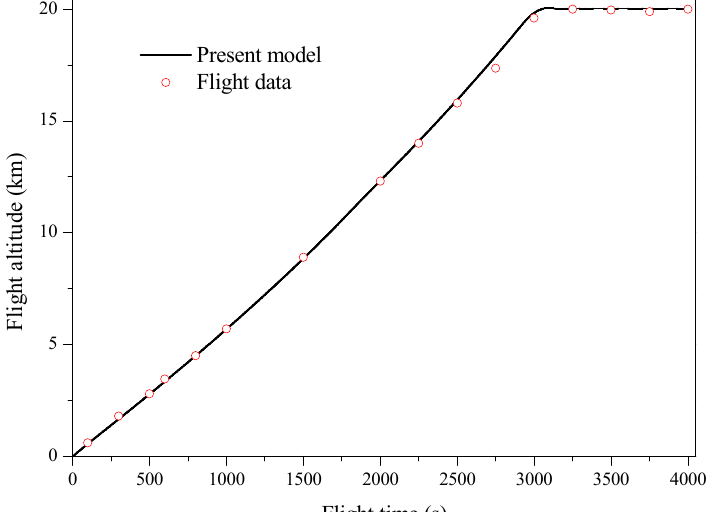
Figure 5. Comparison between the predicted data and the experimental data (flight altitude).